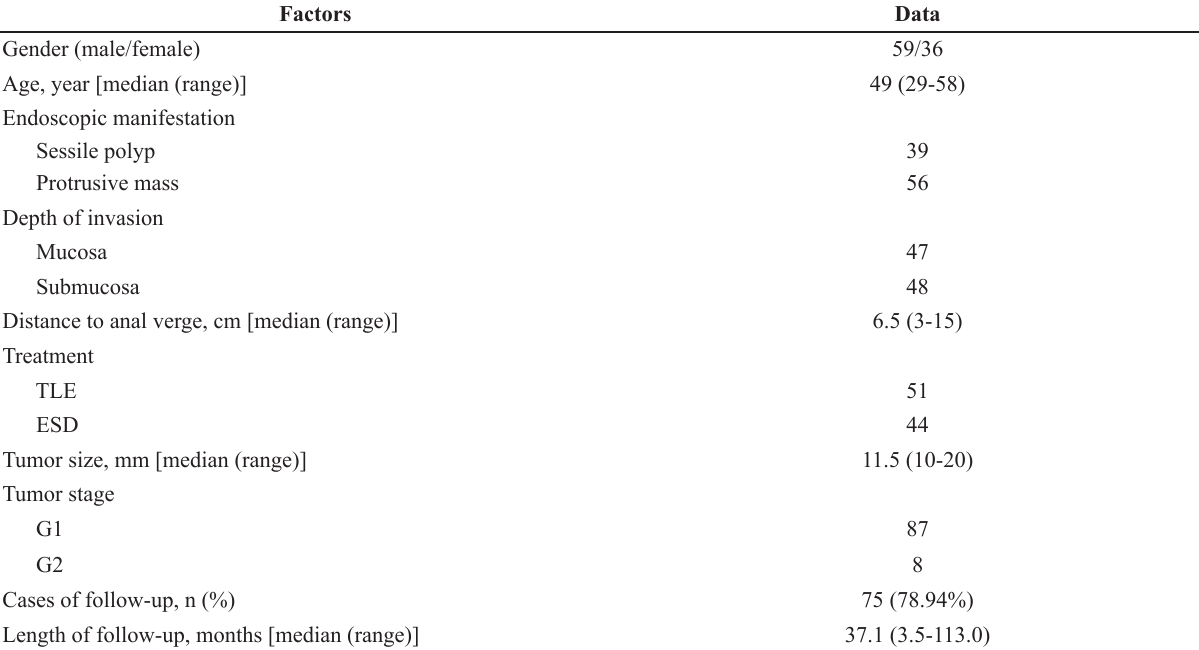
Table 1. Clinical characteristics of patients.